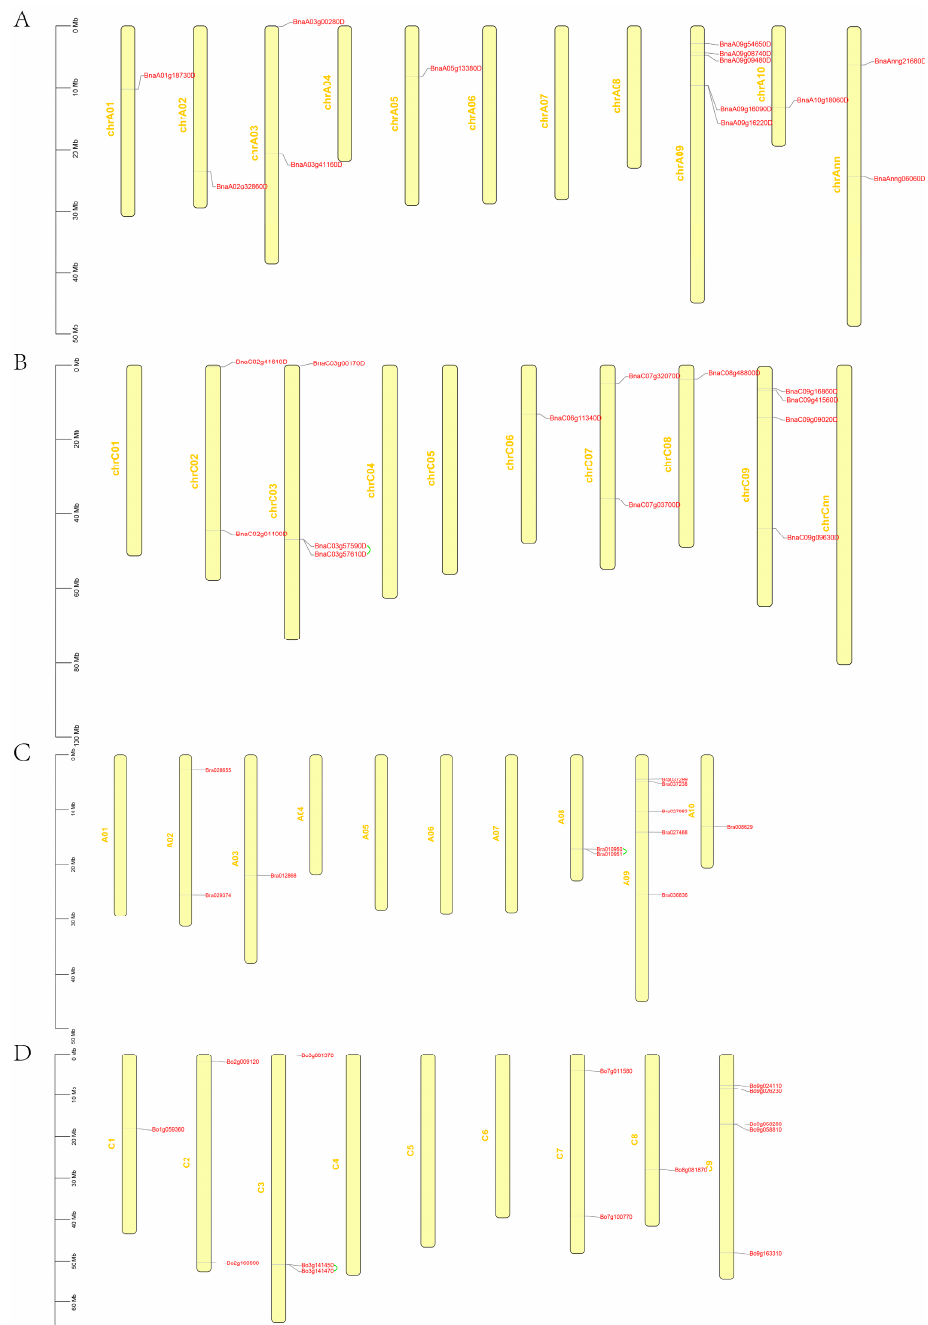
Figure 2. Locations of Brassica GYFs on chromosomes. ( A , B ) Locations of GYF s on A or C subgenome in Brassica napus . ( C ) Locations of GYFs on chromosomes in Brassica rapa . ( D ) Locations of GYFs on chromosomes in Brassica oleracea . A01-A09, C1-C9, and chrA01-chrCnn represent the chromosome number in B. rapa , B. oleracea , and B. napus , respectively. The green line represents tandem duplication.